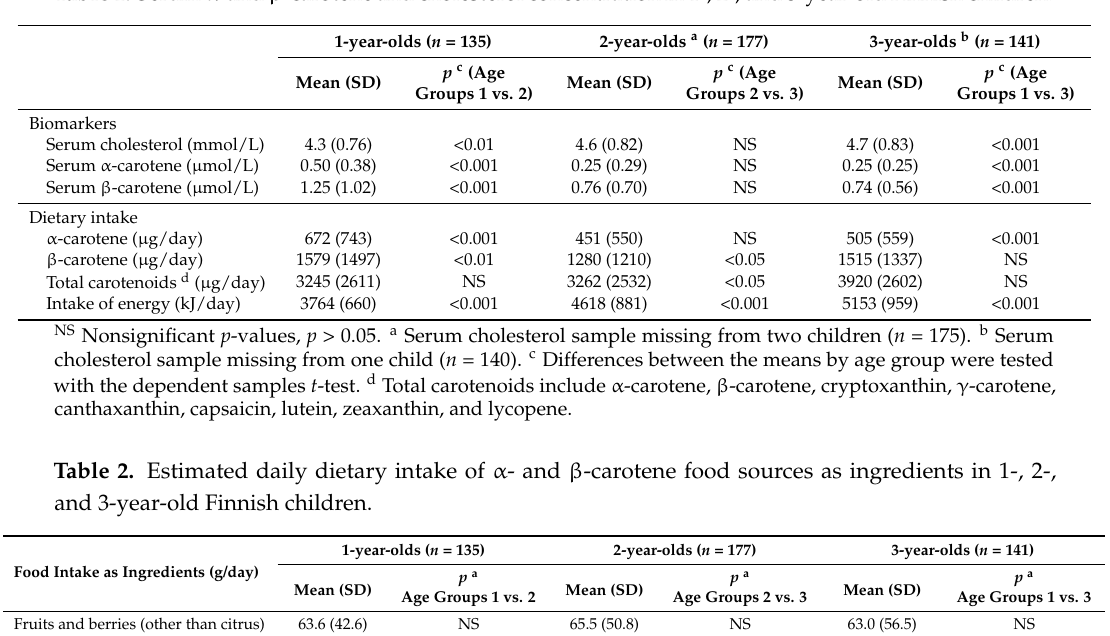
Table 1. Serum α -and β -carotene and cholesterol concentration in 1-, 2-, and 3-year-old Finnish children.